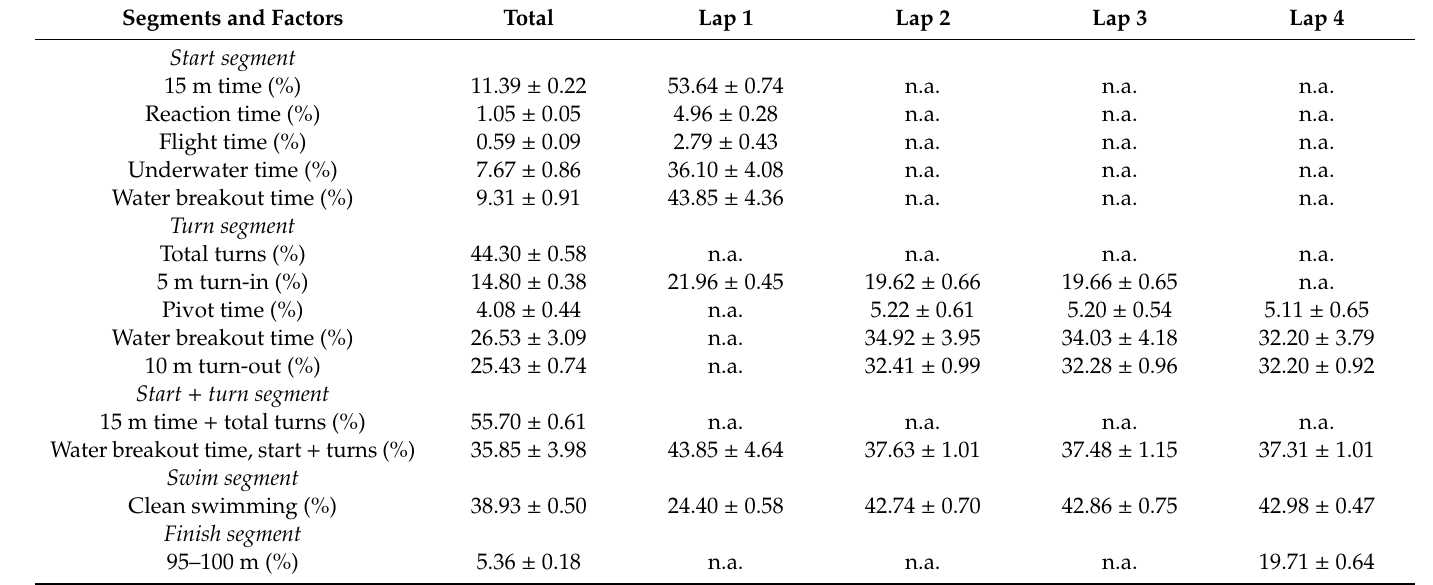
Table 9. Partial contribution (mean ± standard deviation) from the di ff erent segments to the finishing